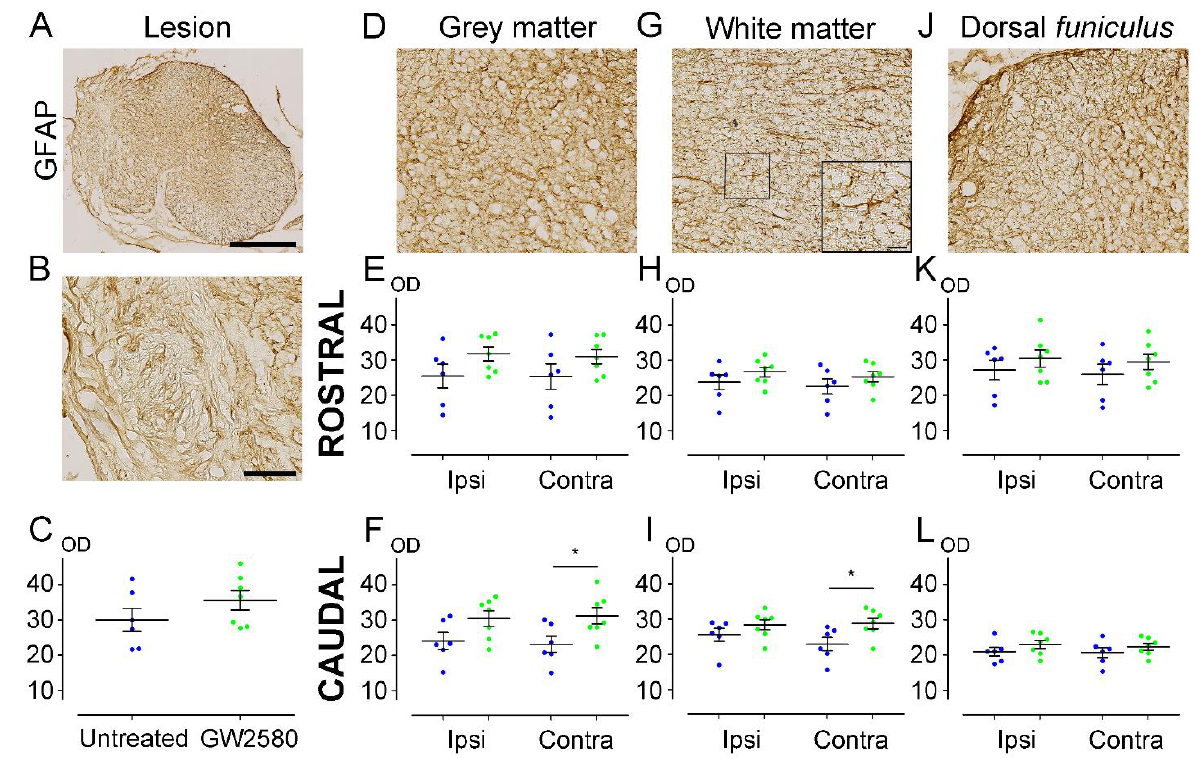
Figure 4. Long-term GW2580 treatment after SCI increases GFAP immunoreactivity in the spinal cord. Representative micrograph of GFAP immuno-staining at the lesion epicenter ( A ). Zoomed-in micrographs in the lesion site ( B ), the grey matter ( D ), the white matter ( G ), and the dorsal funiculus ( J ) at the lesion epicenter. Six weeks after SCI, quantifications of GFAP immunoreactivity were done in the lesion site ( C ), the grey matter ( E , F ), the white matter ( H , I ), and the dorsal funiculus ( K , L ). Optical densities were measured rostral ( E , H , K ) and caudal to the lesion site ( F , I , L ) ipsilateral and contralateral to the lesion site. Results are expressed as mean ± SEM in untreated (blue) and GW2580-treated groups (green). Each dot corresponds to a minimum of 9 sections (630 µ m interval between each section). Statistics: Student’s unpaired t -test. Number of mice: 6 for the untreated group and 7 for the GW2580-treated group. * p < 0.05. scale bars: 500 µ m ( A ); 100 µ m ( B , D , G , J ). 20 µ m ( G ) (right bottom corner).